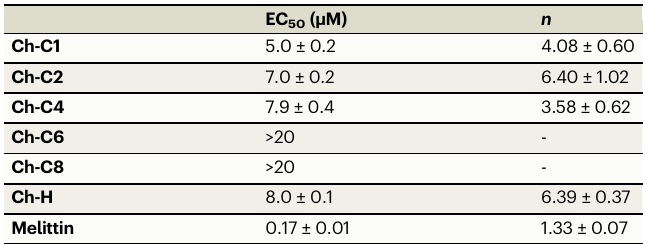
Table 1 | EC 50 values (µM) determined using CF-leakage assay